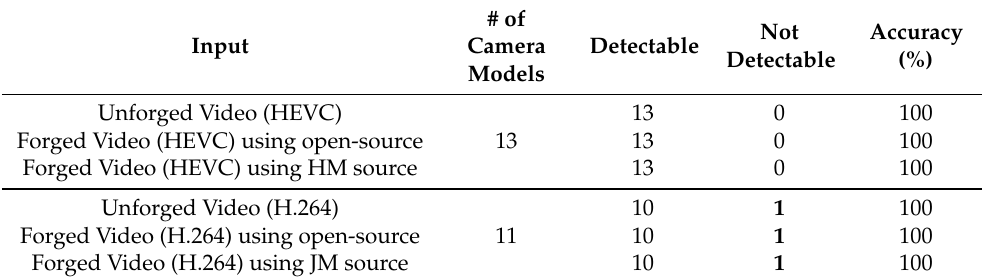
# of Not Accuracy Camera Detectable Detectable (%) Models